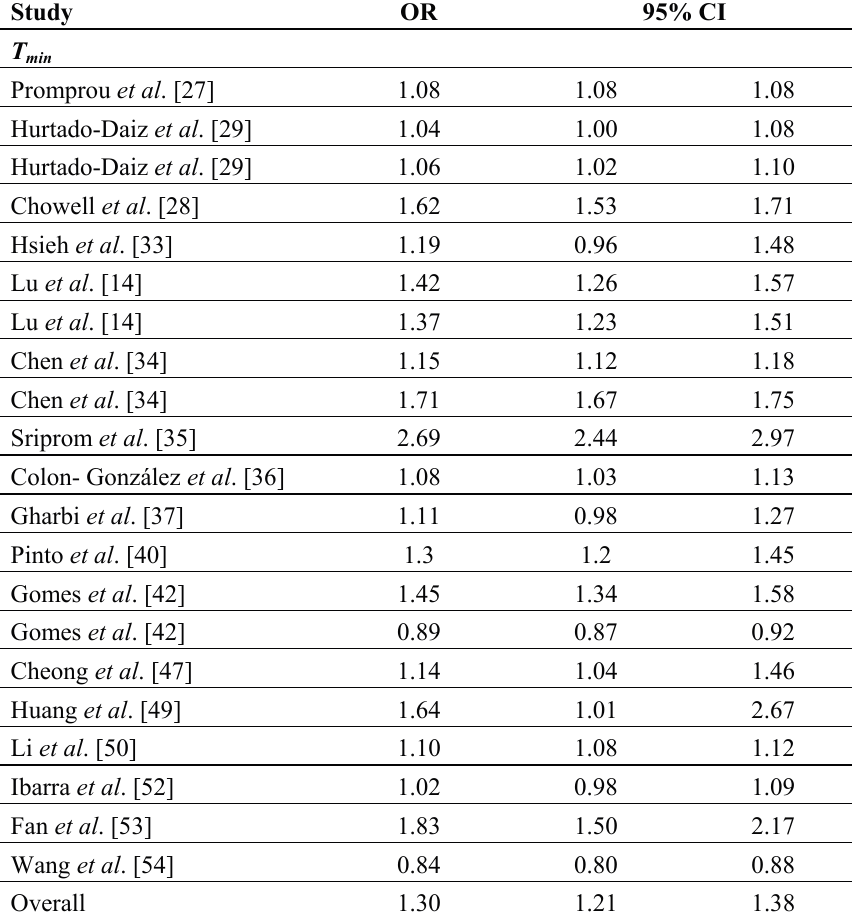
, T and T and DF risk in meta-analysis min max mean